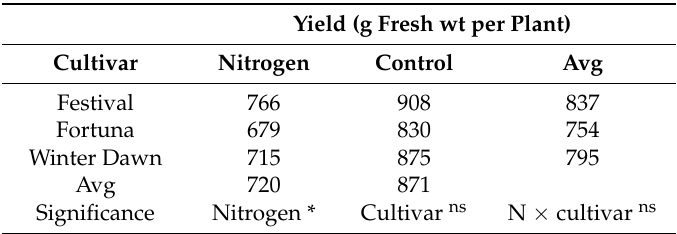
Table 1. Effects of nitrogen fertiliser on the yield of three strawberry cultivars grown in Queensland, Australia in